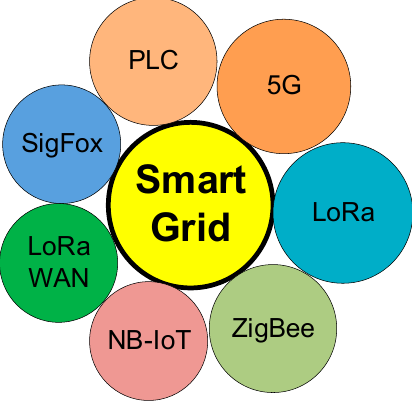
Figure 1. Technologies identified in the smart grid concept.